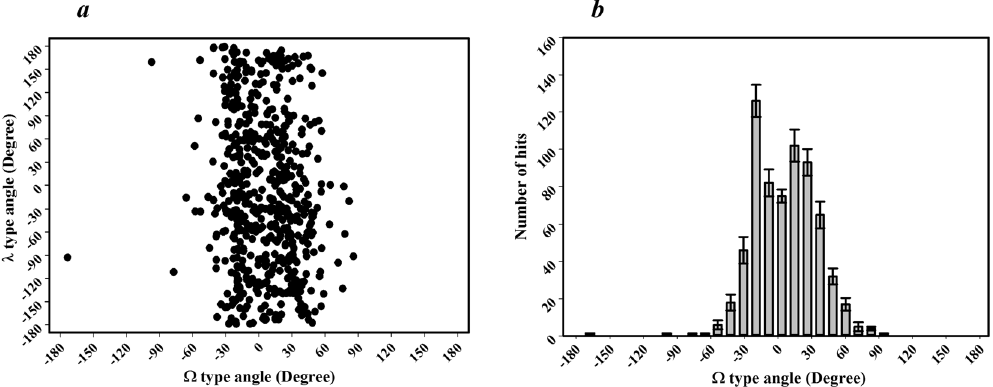
Figure 4. Distribution of the Ω type and λ type dihedral angles in the helical membrane proteins. ( a ) Ω- λ distribution plot for the helical membrane proteins. All Ω and λ type dihedral angles in the 103 non- homologous of membrane proteins are plotted together in the 2-D scatter plot (Ω type: x-axis, λ type: y-axis). ( b ) Histogram showing the overall distribution of the Ω type dihedral angles. Error bars were the standard deviations estimated by bootstrap method 44 , resampling the data 500 times with replacement and repeating the